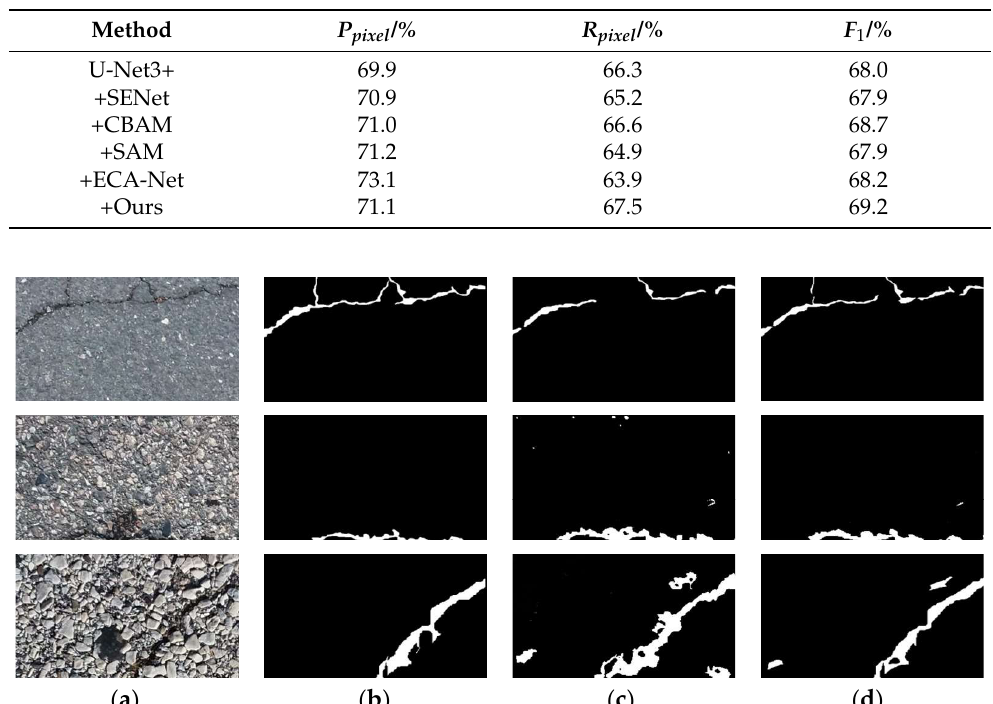
Table 1. The results of different attention mechanisms.